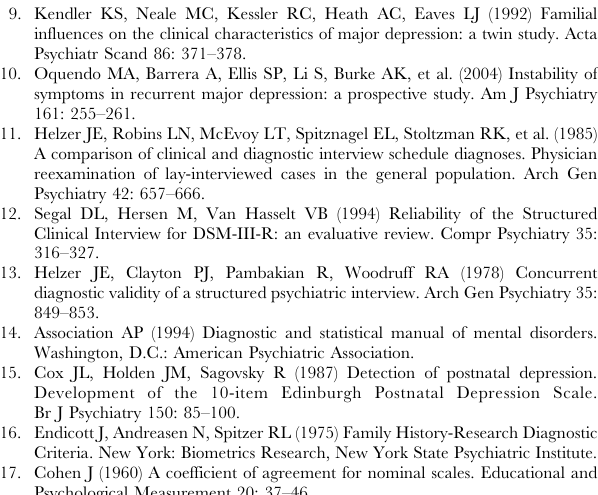
Medical record factor Interview factor